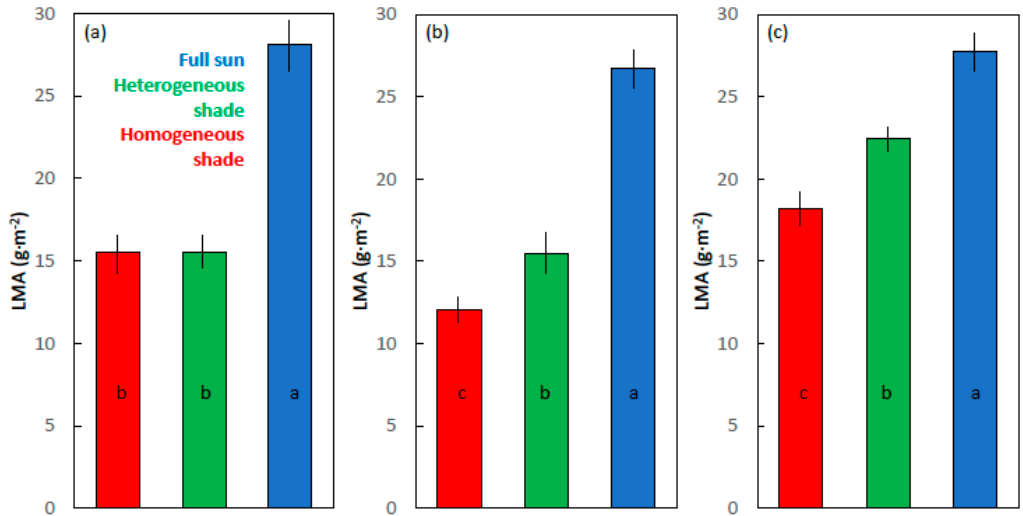
Figure 5. Leaf mass per area (LMA) of the ( a ) Cycas micronesica , ( b ) Zea mays , and the ( c ) Glycine max leaves. For each species, the leaves were grown in homogeneous 62% sunlight exclusion under a shade screen, heterogeneous 62% sunlight exclusion under a slat-house, or full sunlight. Bars with the same letter within each species are not di ff erent according to Tukey’s honest significant di ff erence test. Mean ± SE, n = 4.